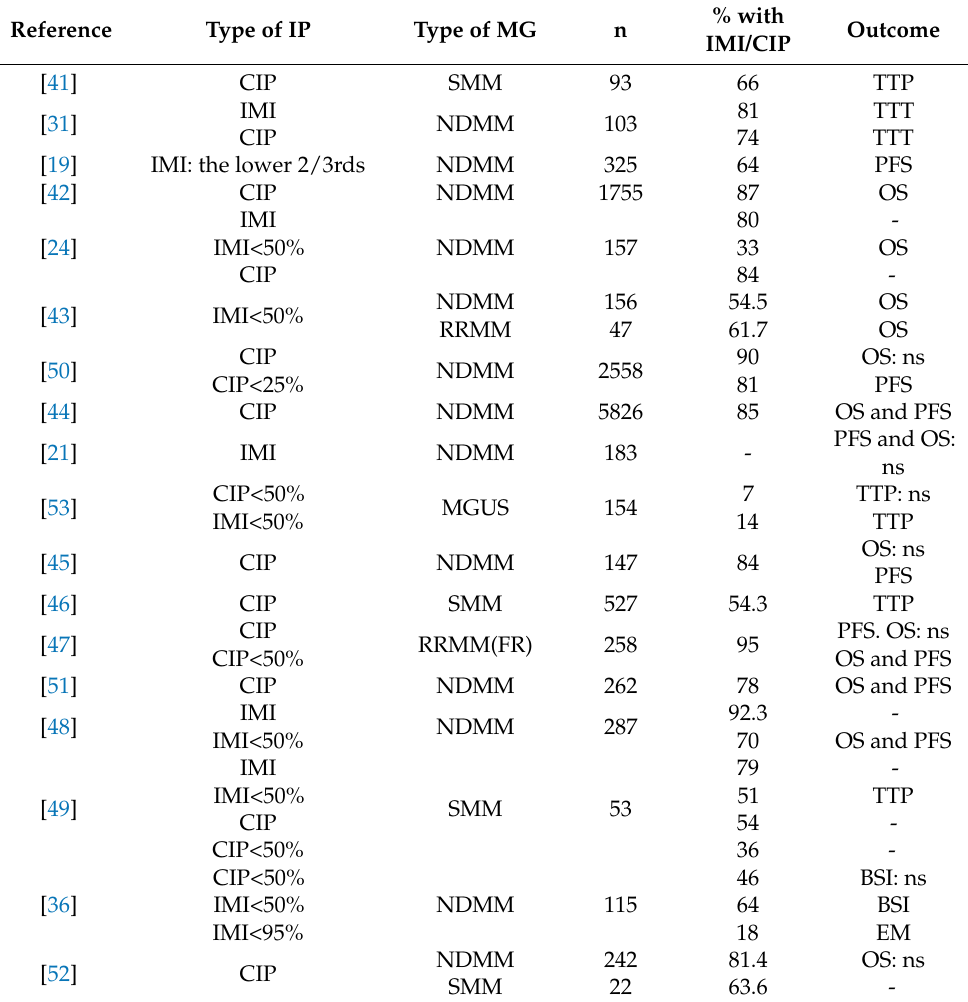
Table 5. Prognostic value of baseline isotype-matched immunoparesis (IMI) and/or classical im- munoparesis (CIP) observed in different